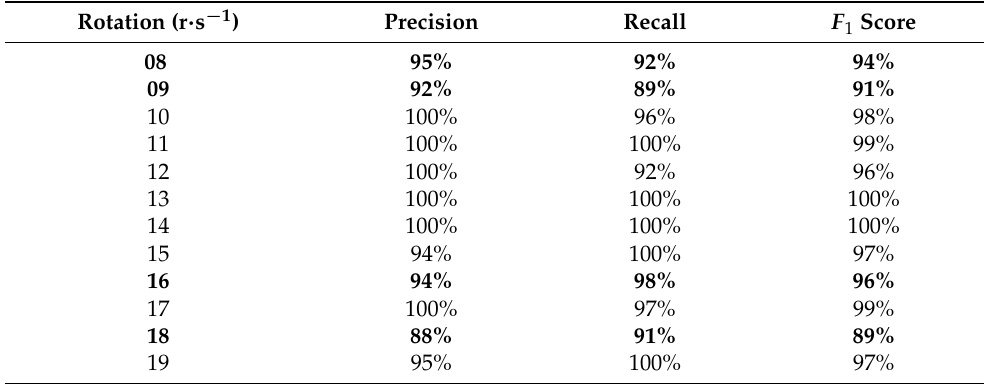
Table 7. Evaluation metrics for LOFAR+COMB when feeding into the CRNN for F 0 estimation on the simulation dataset, two pairs of rotations with integral multiplication relationship are highlighted in bold